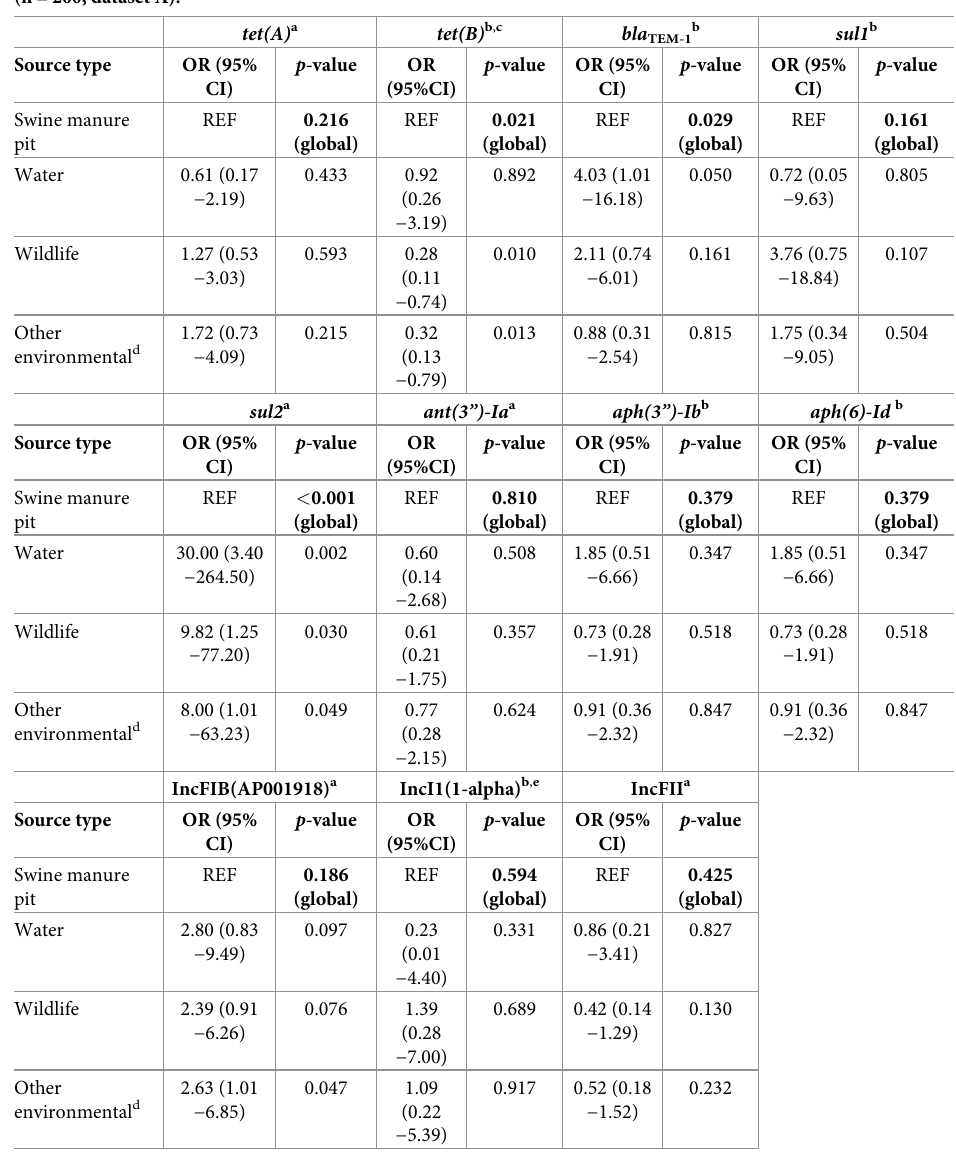
Table 5. Logistic regression models a,b,c assessing the association between source type and the occurrence of select plasmid incompatibility types and antimicrobial resistance genes in phenotypically resistant Escherichia coli iso- lates collected from wildlife, swine manure pits, and environmental sources in southern Ontario, 2011 − 2013 (n = 200, dataset